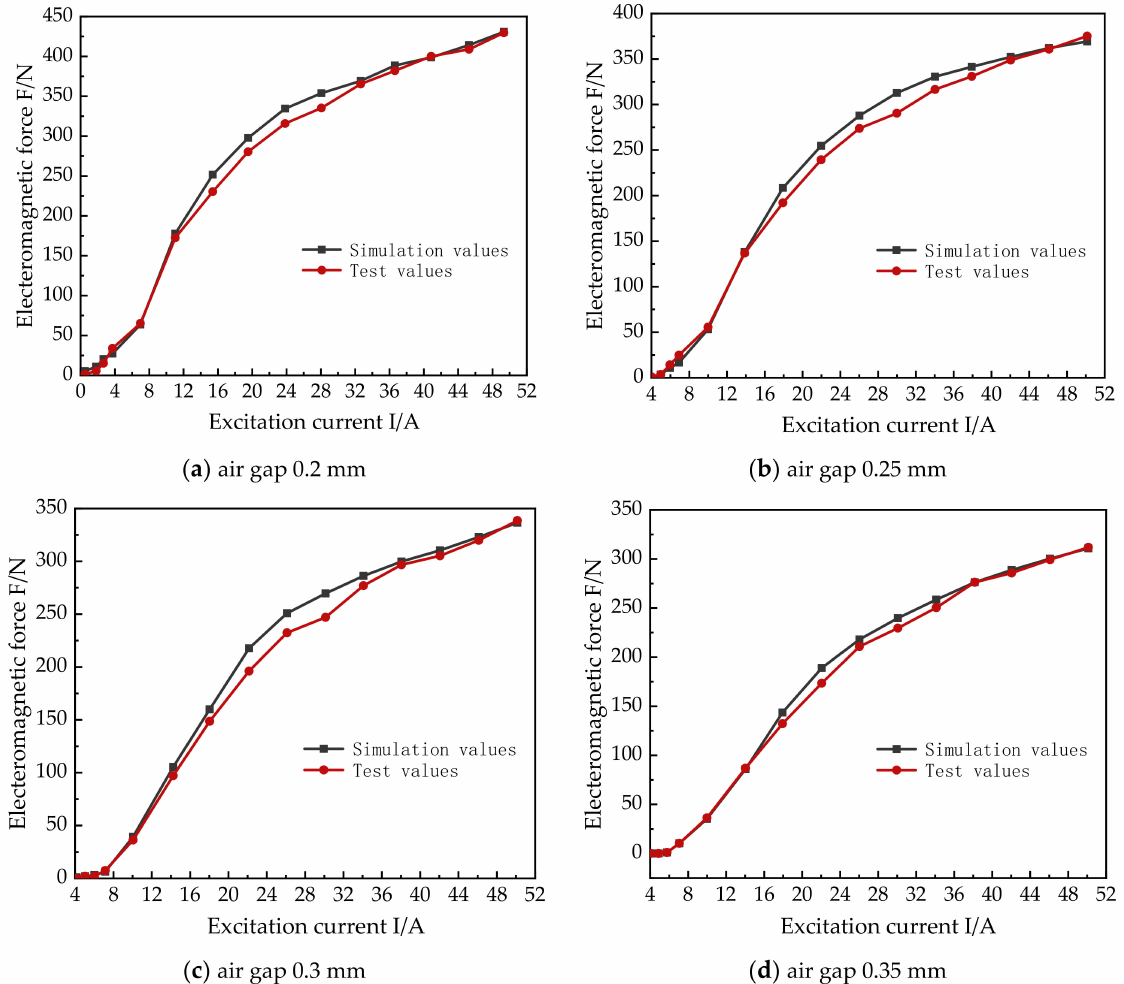
Figure 9. Comparison of simulated and experimental values of static electromagnetic suction force under different working air gaps.